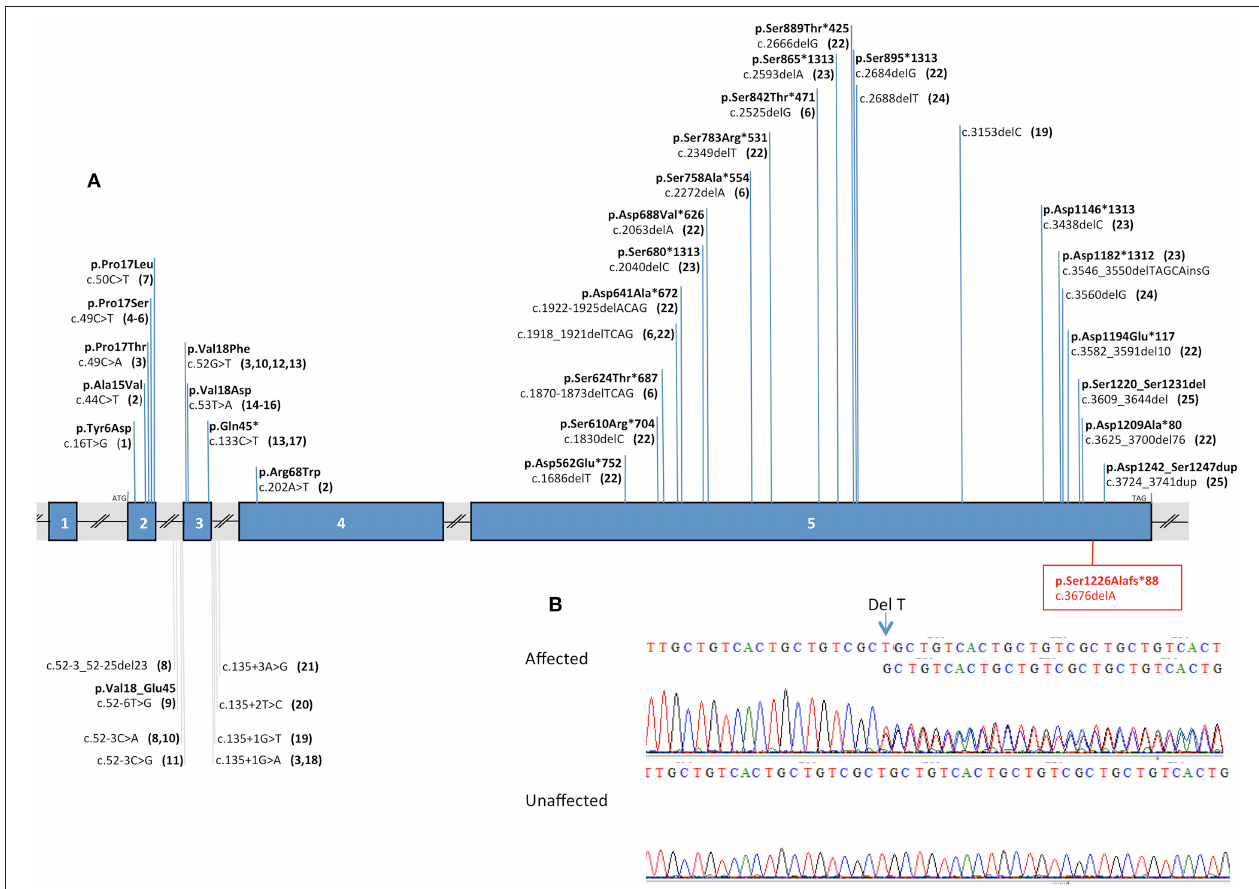
FIGURE 3 | DSPP mutation analysis. DSPP mutations are indicated against the gene structure (reference sequence: NM_014208.3). (A) Schematic representation of DSPP : this gene contains 5 exons (vertical blue hatches), the position of the start codon (ATG) and the stop codon (TAG) are indicated respectively in exon 2 and exon5. The known mutations in the DSPP gene are summarized against the gene structure and associated to a literature reference. The new mutation described in this paper is boxed and written in red. For example: the most 5 ′ DSPP mutation, near the initiation codon (ATG) is lying in exon 2 and described as a single nucleotide variant c.16T > G leading to the following amino acid changes in the protein p.Tyr6Asp and reported in the literature in quoted reference ( Rajpar et al., 2002). (B) Electrophoregrams of a part of DSPP exon 5 showing the heterozygous mutation in an affected person and the normal sequence in an unaffected individual. The deletion of 1T is indicated with an arrow, this deletion creates a shift in the reading frame in position 3676 of the cDNA reference sequence, resulting in 2 superposed sequences. On the scheme the numbering corresponds to the following references: 1 . Rajpar et al. (2002); 2 . Malmgren et al. (2004); 3 . Xiao et al. (2001); 4 . Zhang et al. (2007) and Qu et al. (2009); 5 . Hart and Hart (2007); 6 . Mcknight et al. (2008a); 7 . Li et al. (2012) and Lee et al. (2013); 8 . Wang et al. (2009); 9 . Lee et al. (2008); 10 . Holappa et al. (2006); 11 . Kim et al. (2004); 12 . Kim et al. (2005); 13 . Song et al. (2006); 14 . Lee et al. (2011b); 15 . Kida et al. (2009); 16 . Lee et al. (2009); 17 . Zhang et al. (2001); 18 . Wang et al. (2011); 19 . Mcknight et al. (2008b); 20 . Zhang et al. (2011); 21 . Bai et al. (2010); 22 . Nieminen et al. (2011); 23 . Song et al. (2008); 24 . Lee et al. (2011a); 25 . Dong et al.